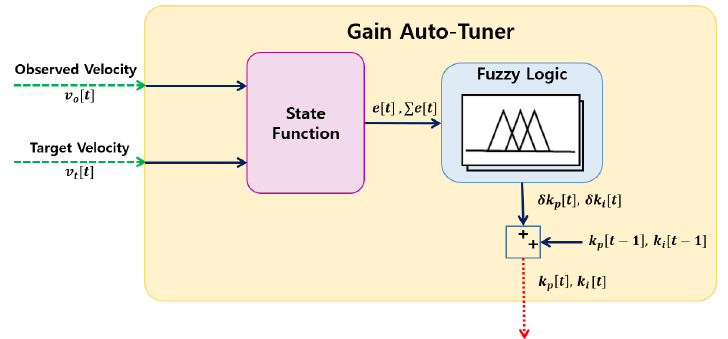
Figure 10. Fuzzy-Logic-Based Gain Autotuner.